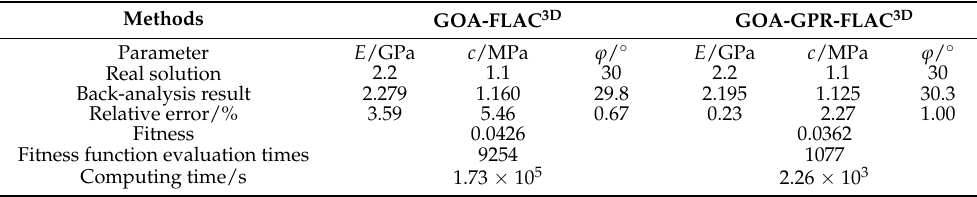
Table 4. The results calculated by the two methods.